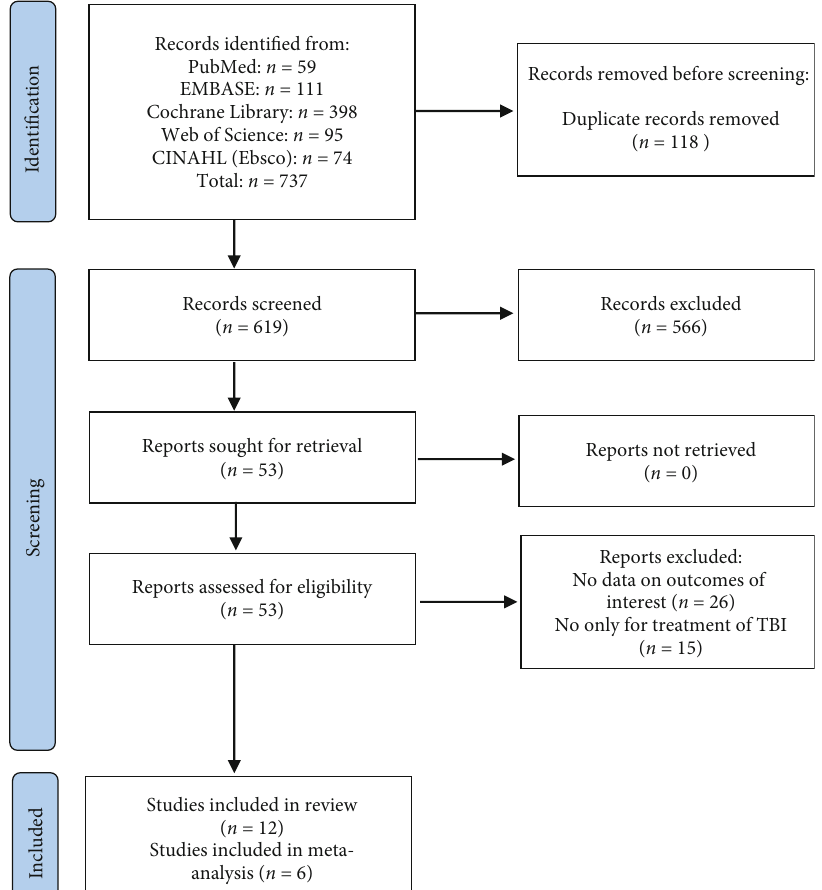
Figure 1: PRISMA fl ow diagram of studies in this